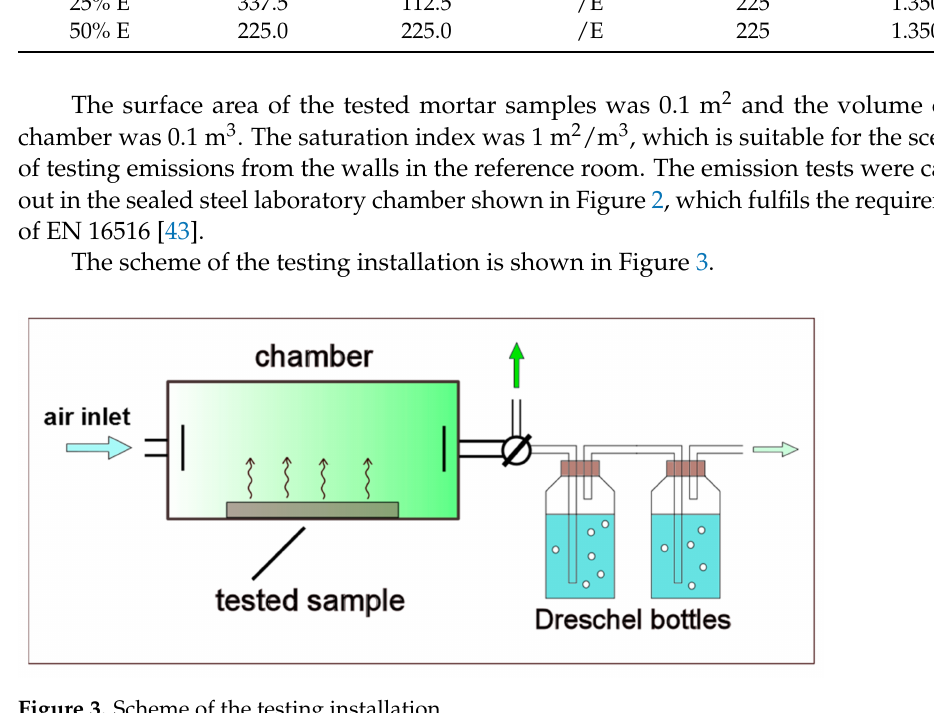
Figure 3. Scheme of the testing